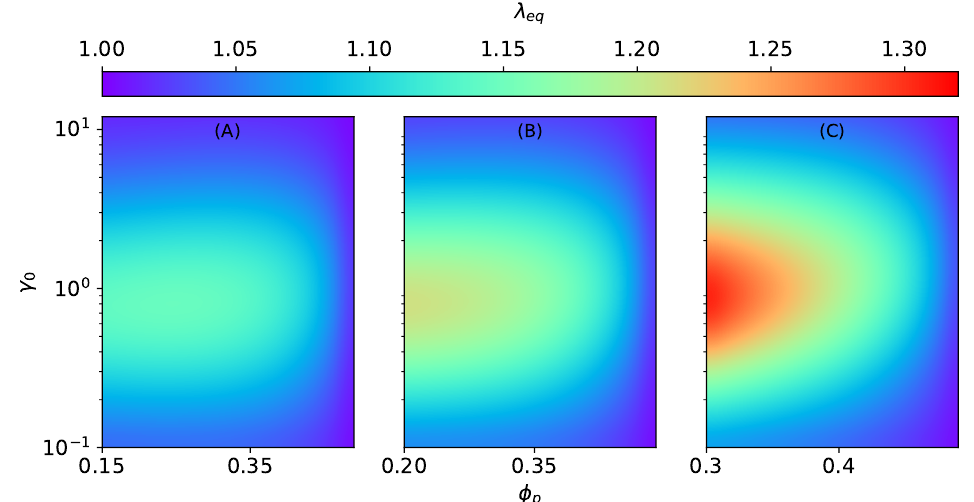
Figure 4. The magneto-induced elongation λ eq for MAEs with SC microstructure as a function of the initial aspect ratio γ 0 and the volume fraction φ p at constant | (cid:126) H 0 | = 470 kA/m, G m = 17 kPa. ( A ) φ = 0.15, ( B ) φ = 0.2, ( C ) φ =